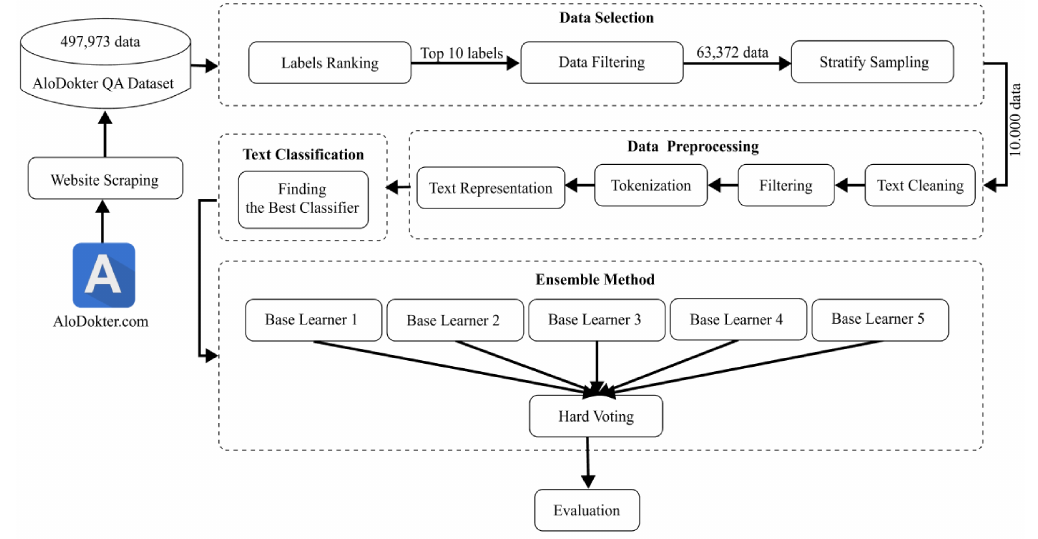
Fig. 1. A mechanism for multi-label classification with ensemble